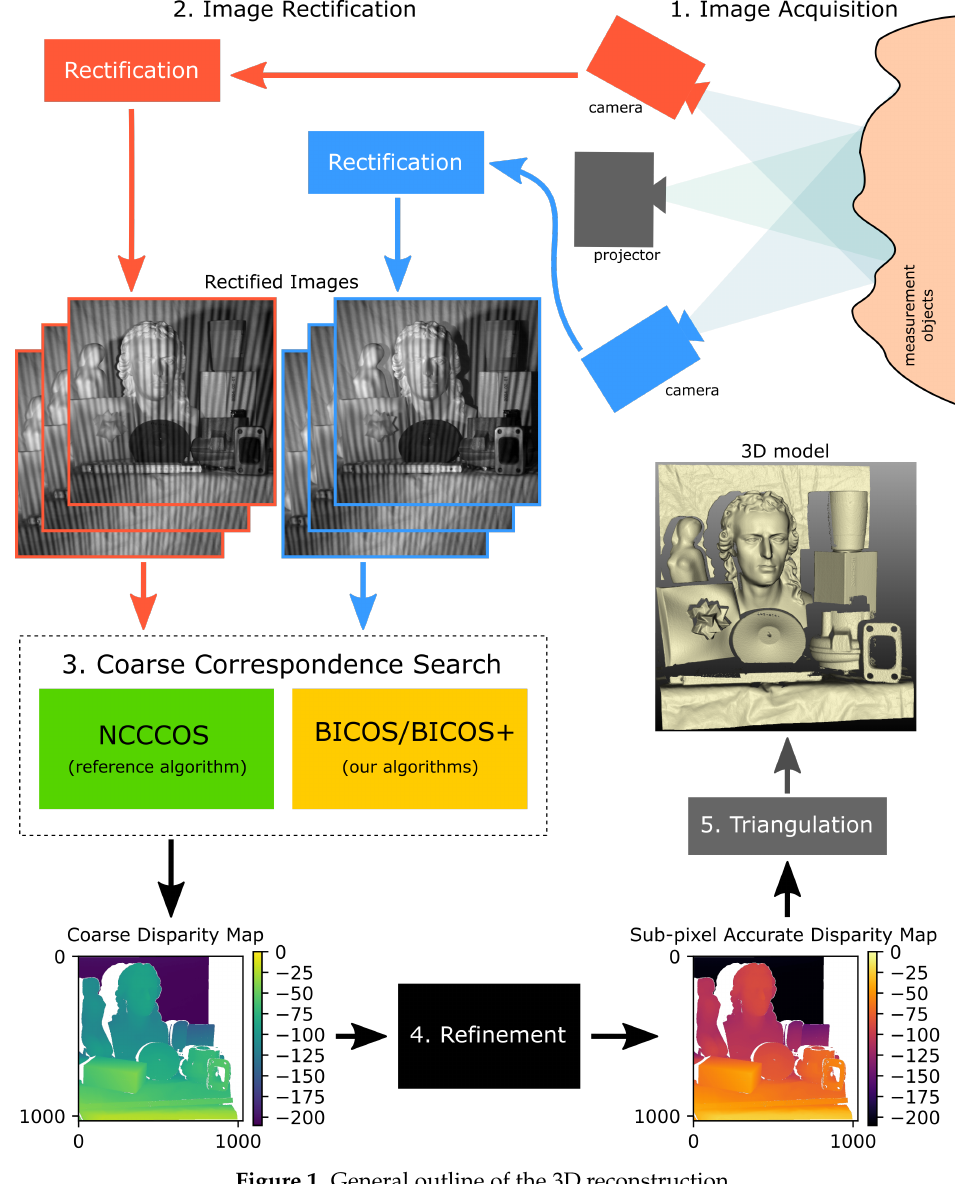
Figure 1. General outline of the 3D